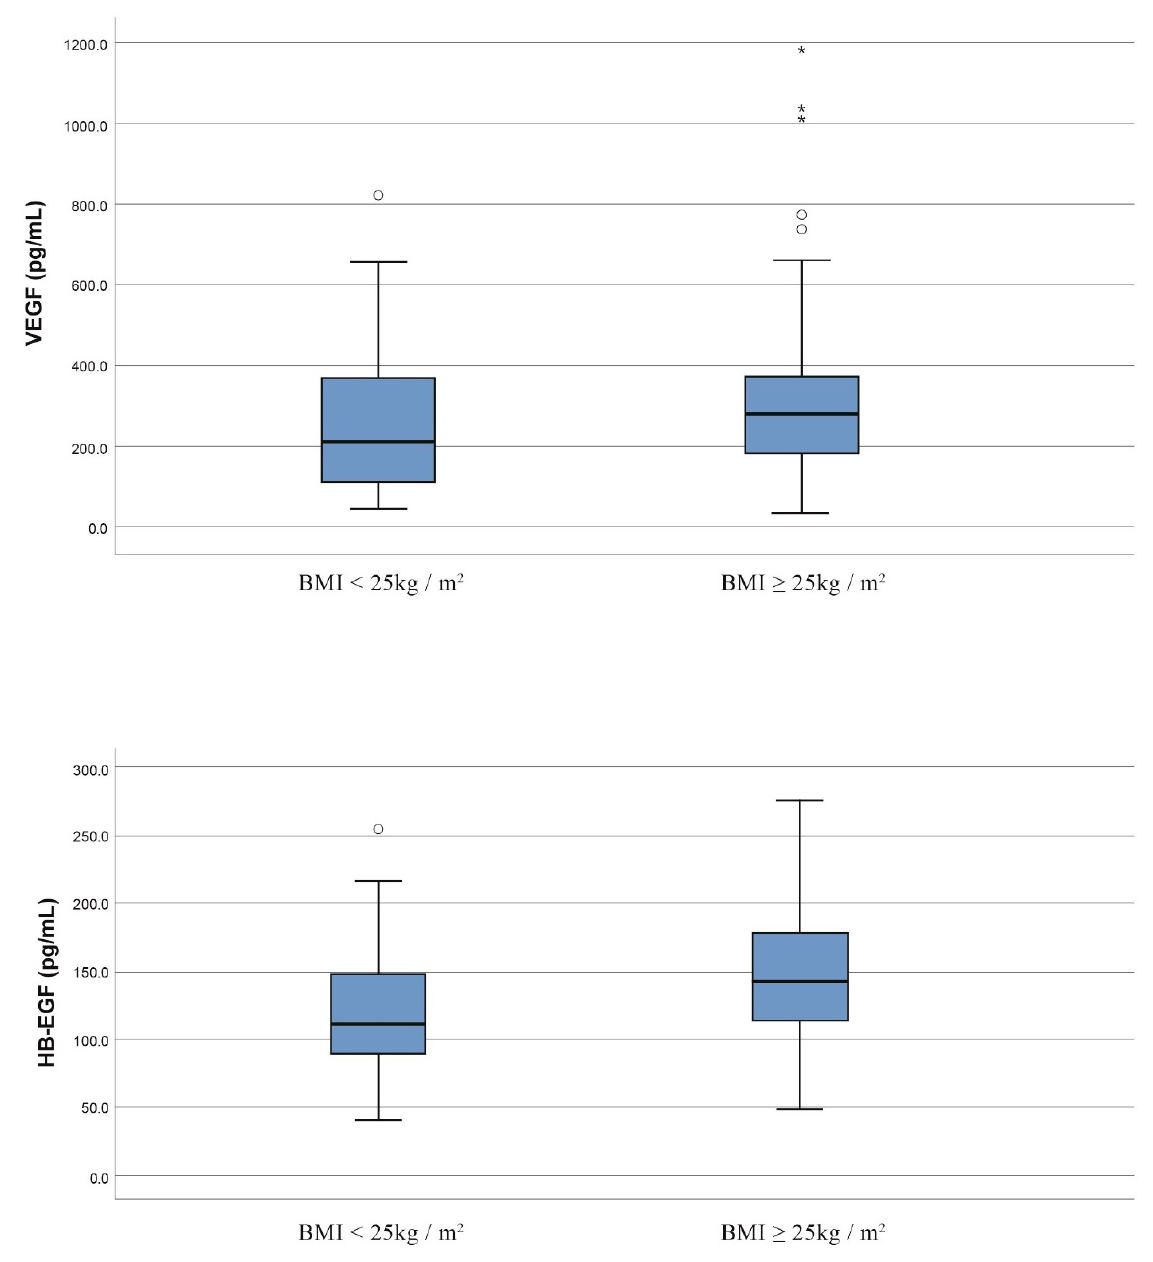
Figure 3. Box plots of VEGF and HB-EGF serum levels according to the BMI status of patients with breast cancer.